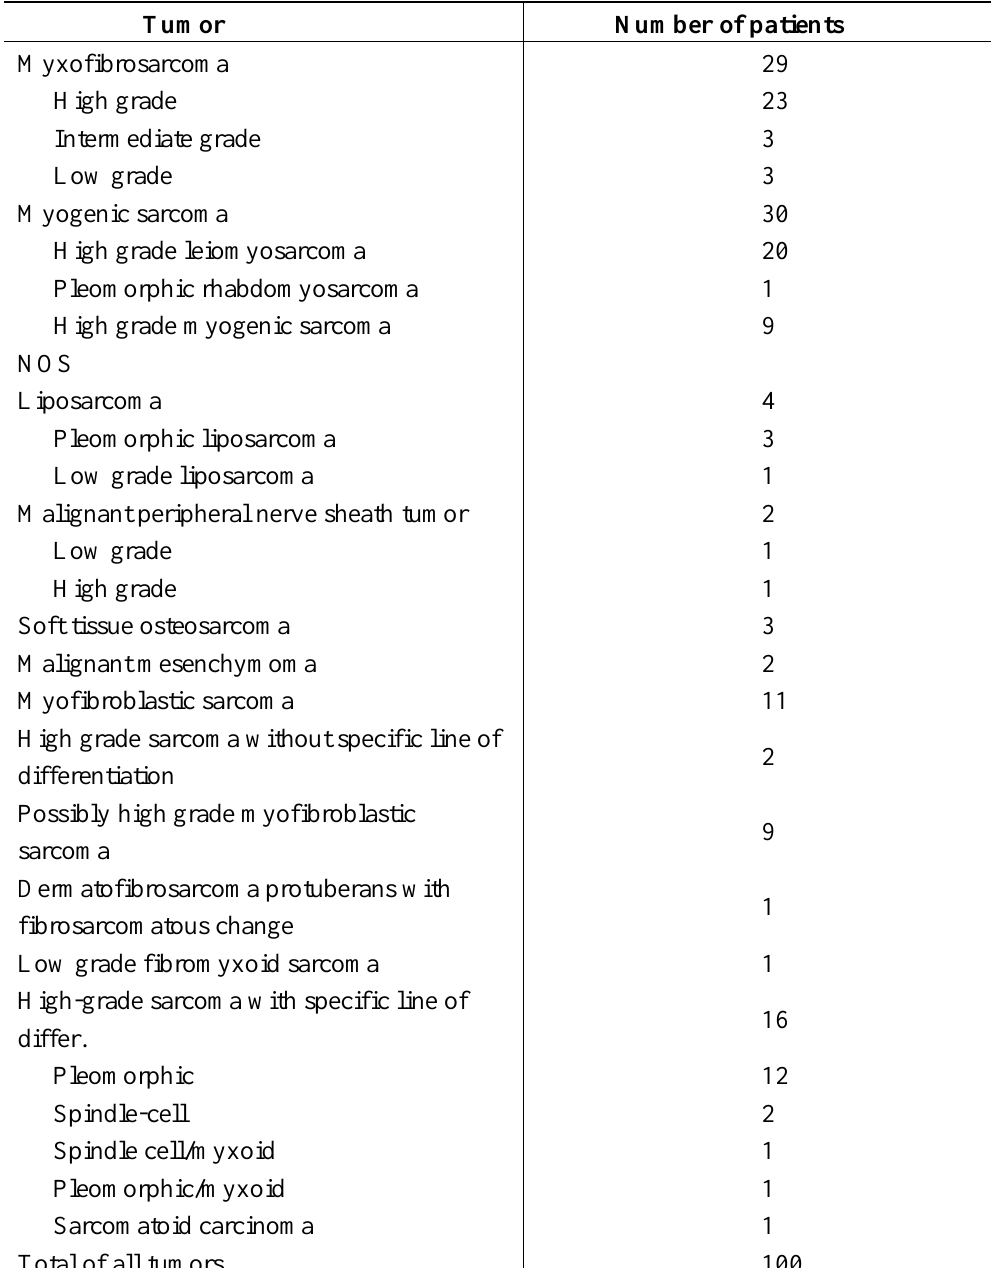
Table 1. Diagnosis after re-evaluation of 100 soft tissue sarcomas of the extremities and trunk wall. Cases initially diagnosed as MFH in 1964–1997. Data derived from the data registry of the Musculoskeletal Tumour Center, Lund,